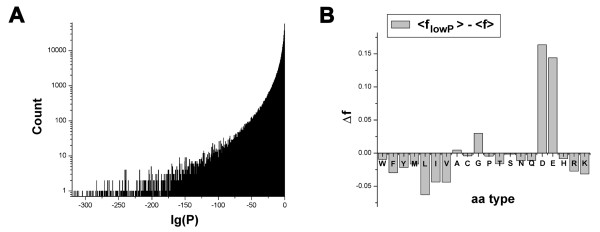
Comparison of residue frequencies in multiple alignments of sequence homologs to the structure-based frequency predictions. A. Histogram of P-values (log-log scale). B. Difference in residue frequencies between 0.3% alignment positions with lowest P-values and the whole population. Frequencies of glutamate and aspartate show the greatest elevation.